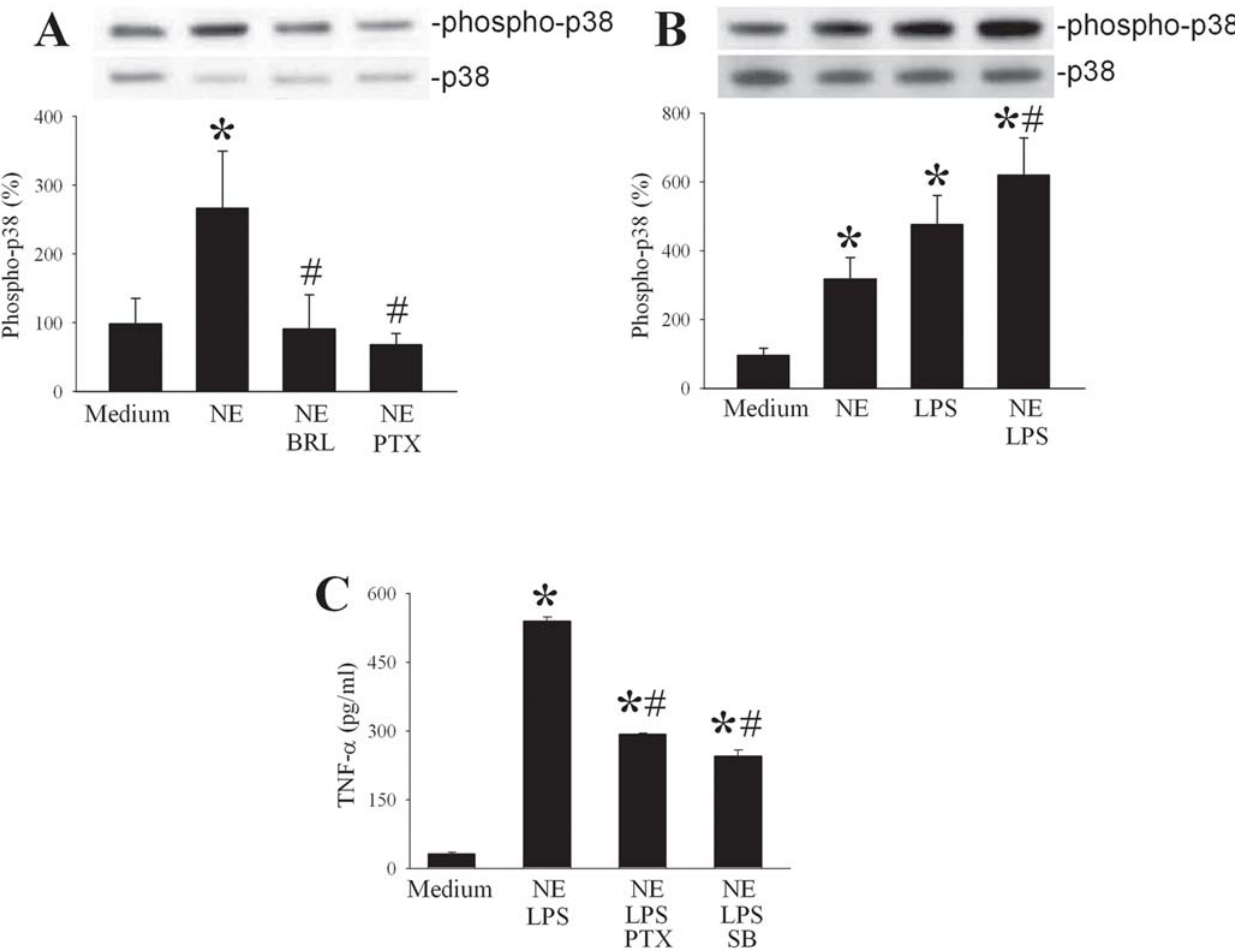
Figure 6. NE-mediated potentiation of p38 MAP kinase phosphorylation via a 2A -ARs. ( A ) Alterations in p38 MAP kinase after 1 h culture with NE alone (20 nM), NE + BRL-44408 (BRL, 1 m M), or NE + pertussis toxin (PTX, 100 ng/ml). The relative percentage of phosphorylated p38/total p38 MAP kinase is presented as mean 6 95% confidence (n=4–6) and compared by ANOVA on Ranks and Student-Newman-Keul’s method. The Medium group is considered as 100%. *P , 0.05 vs. Medium; # P , 0.05 vs. NE alone. Representative gels are presented. ( B ) Enhanced activation of p38 MAP kinase after 1 h culture with a combination of NE (20 nM) and LPS (100 ng/ml). The relative percentage of phosphorylated p38/total p38 MAP kinase ratio is presented as mean 6 95% confidence (n=4–6) and compared by ANOVA on Ranks and Student-Newman-Keul’s method. Medium group is considered as 100%. *P , 0.05 vs. Medium; # P , 0.05 vs. LPS alone. Representative gels are also presented. ( C ) Suppression of TNF- a release from cultured KCs after stimulation with NE (20 nM) + LPS (100 ng/ml) with or without pertussistoxin (PTX, 100 ng/ml), a G a i -protein inhibitor, or SB203580 (10 m M), a p38 MAP kinase inhibitor. Data are presented as mean 6 SE (n=4–6) and compared by one-way ANOVA and Student-Newman-Keul’s method. *P , 0.05 vs. Medium; # P , 0.05 vs. LPS +